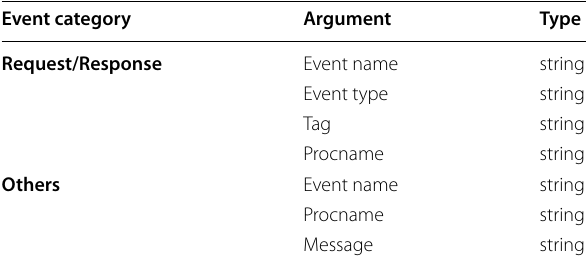
Table 1 The categories of events and the arguments used by our framework